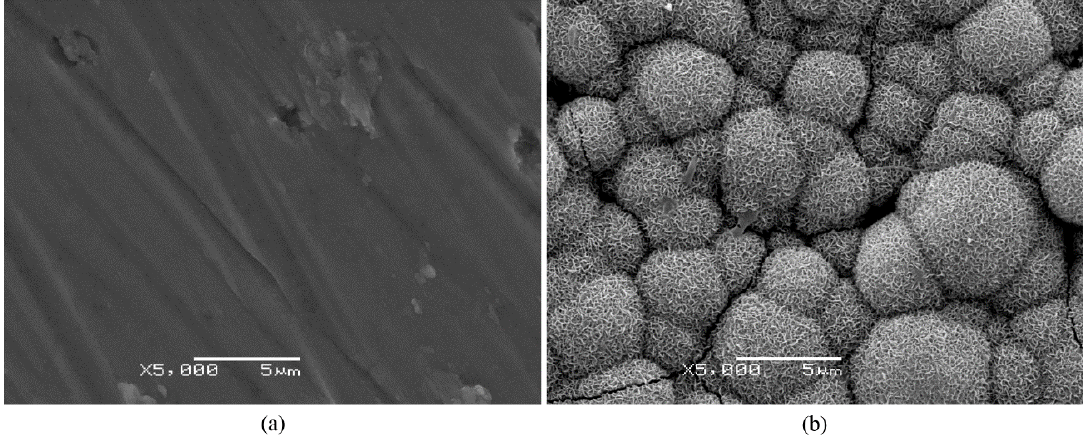
Figure 4. SEM image of Ti6Al4V with TiO grown until 5.0 V (a) before and (b) after 10 days of immersion in SBF at body temperature. 2 The globular morphology is characteristic from the HAP presence.